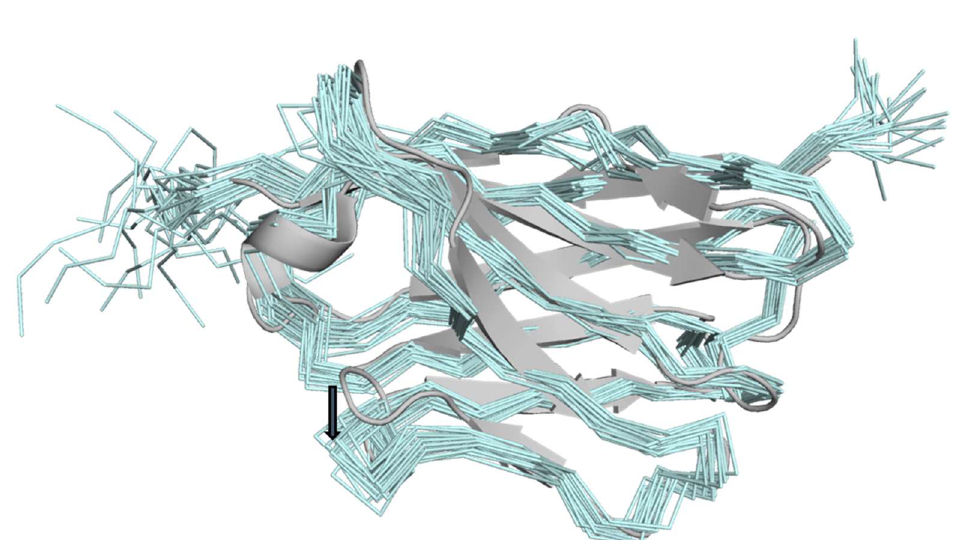
Figure 3. NMR ensemble compared to 3OGO. The NMR ensemble of 20 structures calculated by CYANA (aquamarine) is compared to the crystal structure 3OGO (grey). A dark-grey arrow indicates the displacement of residues 57–69.